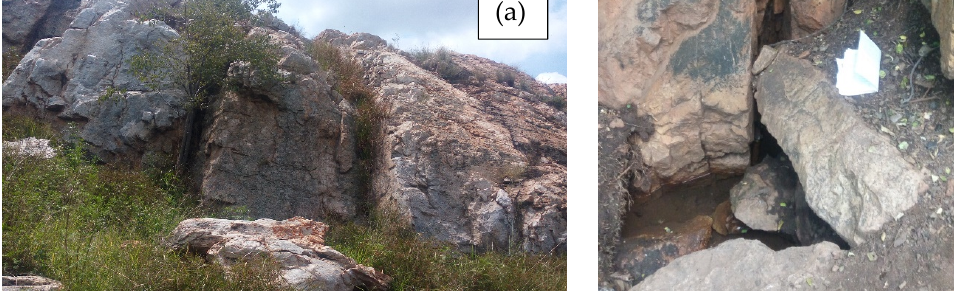
Figure 1. Location map of the study area in the Upper Crocodile River Basin and the South African map also showing the positions of Albert Farm spring and the isotope sampling points.